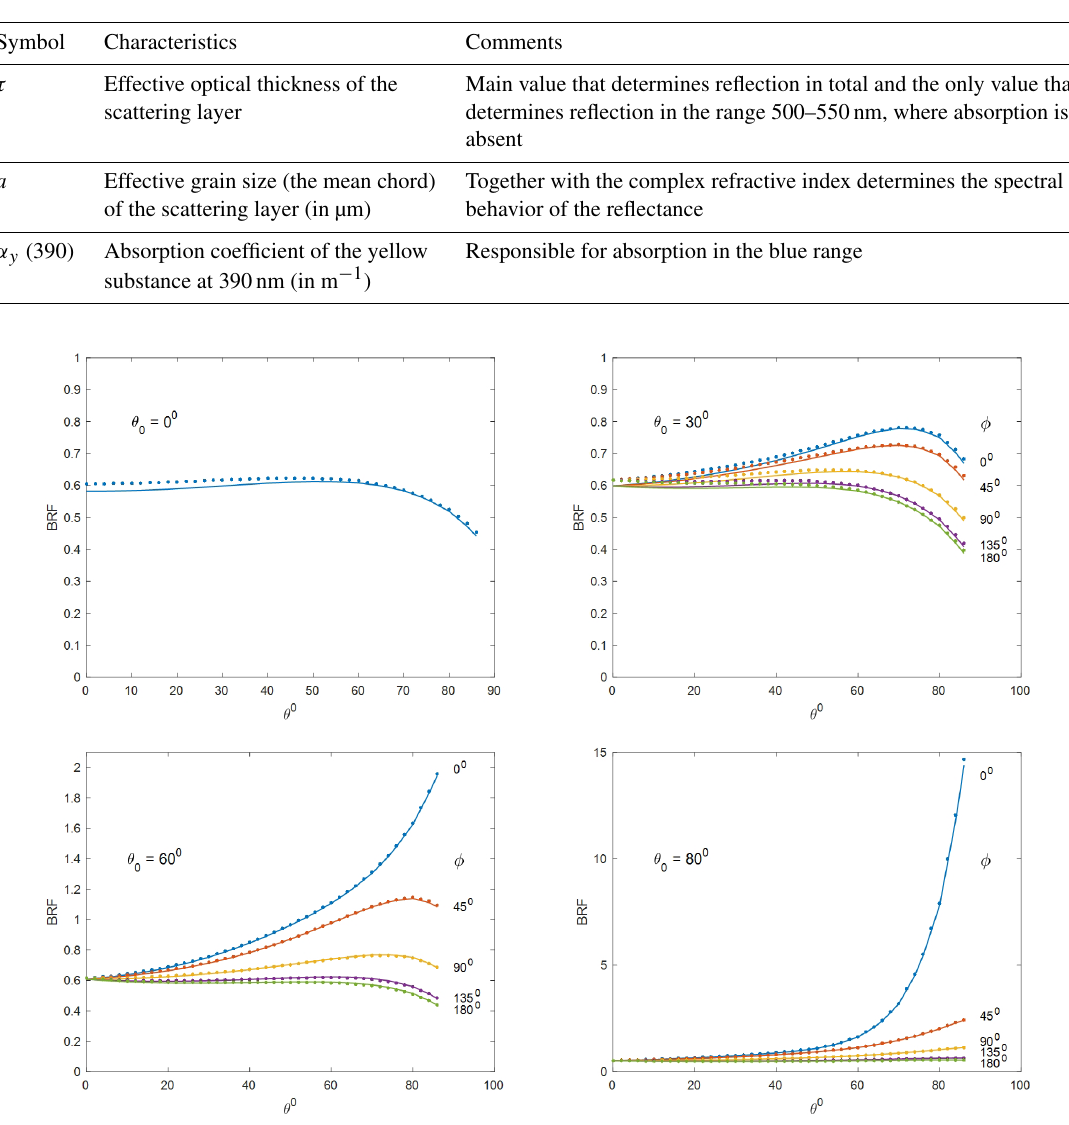
Figure 5. BRF of white ice with τ = 8.5 and a = 3.333mm at 490nm, calculated with the RAY code (dots) and the asymptotic formula